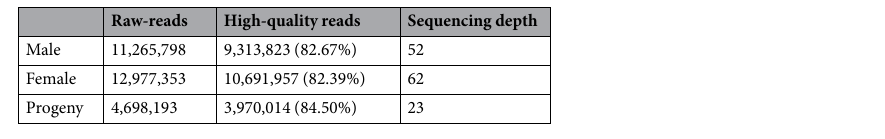
Table 1. Summary of data filtering of